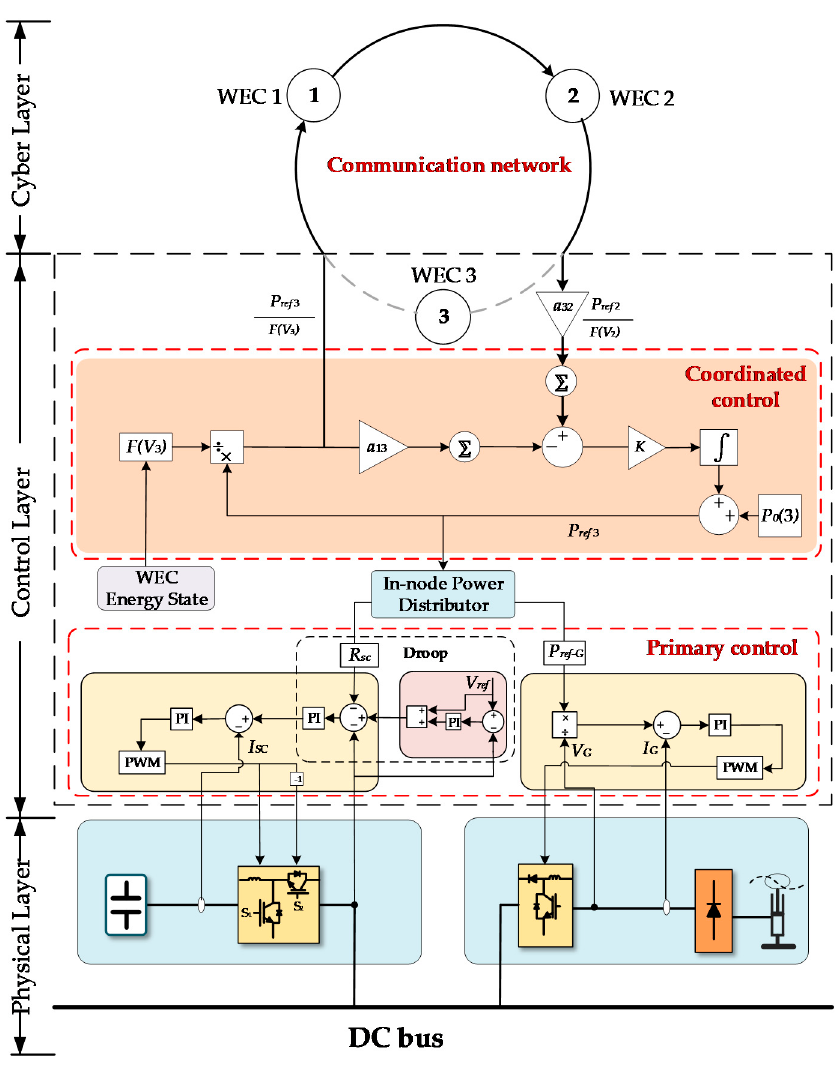
Figure 6. System framework of WECs array.